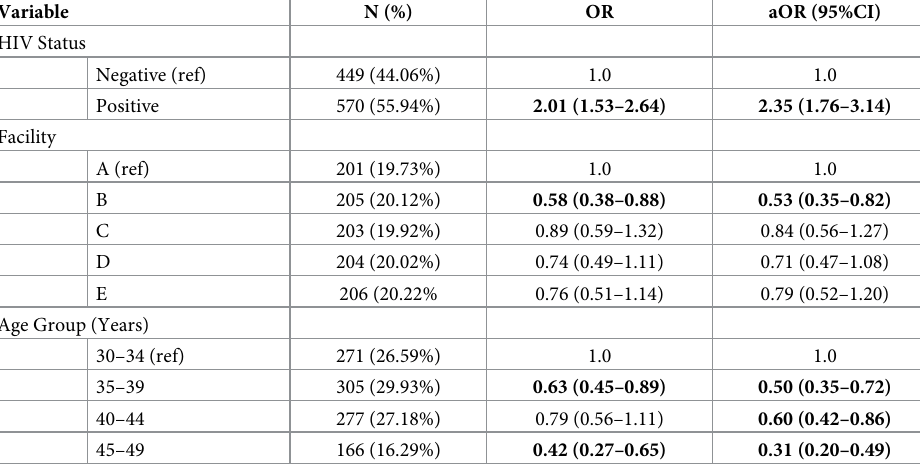
Table 4. Crude odds ratio (OR) and adjusted odds ratios (aOR), with 95% confidence intervals (95%CI), as mea- sures of association of human immunodeficiency virus (HIV) status, health facility, and age-group with prevalent high-risk human papillomavirus (hrHPV) in women living in Botswana.